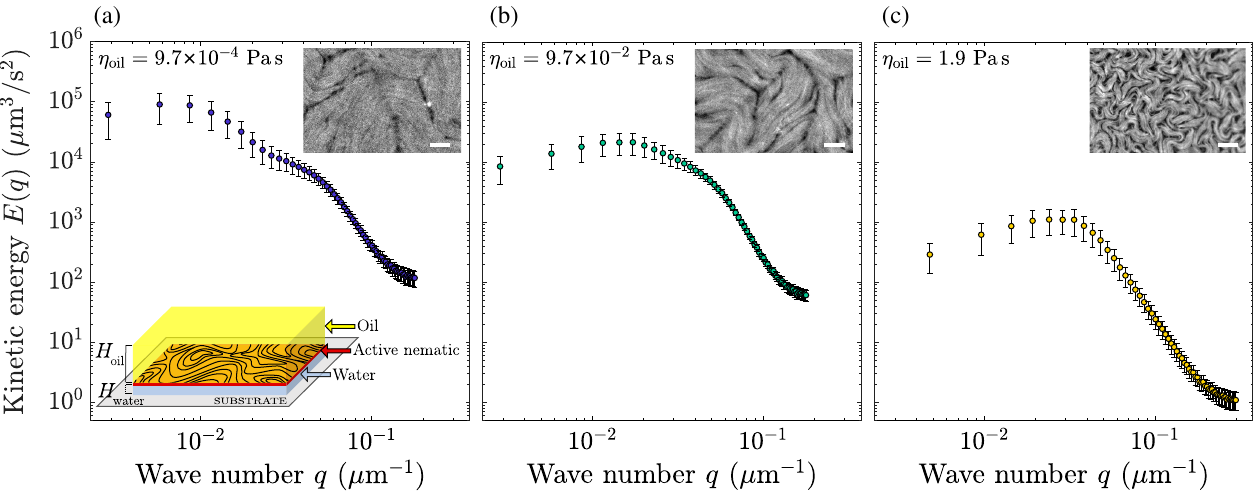
FIG. 1. Oil viscosity modifies the kinetic energy spectrum of active nematic turbulence. (a) – (c) Kinetic energy spectra of turbulent flows in an active nematic film in contact with an oil layer of low (a), intermediate (b), and high (c) viscosity. Averages are over 500 frames. Error bars are standard deviations. In each panel, the top inset shows a representative microtubule fluorescence micrograph. Scale bar is 100 μ m. The bottom inset in (a) shows a schematic of the experimental system. See also Movie 2 in Supplemental Material [52].